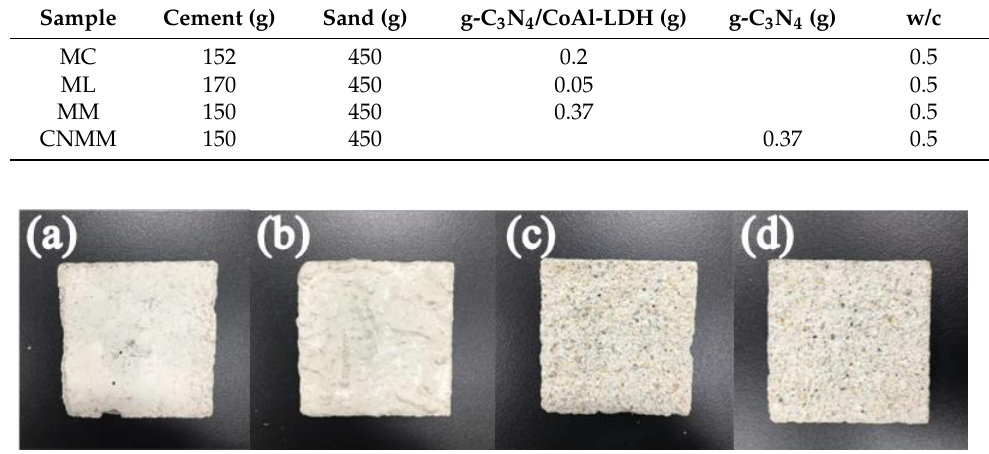
Figure 14. Photocatalytic cement mortars ( a ) MC; ( b ) ML; ( c ) MM; ( d ) CNMM.